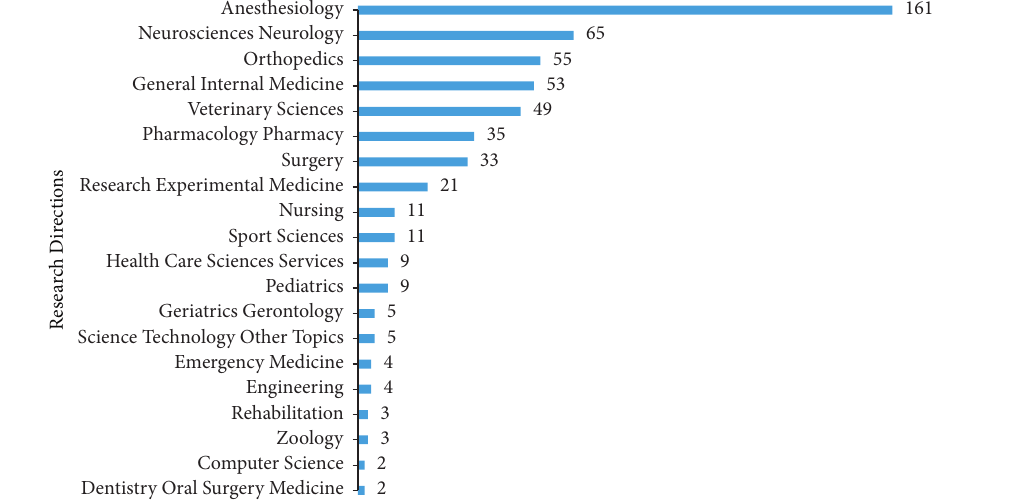
Figure 3: Top 20 research directions with the most publications on analgesics in the treatment of orthopedic postoperative